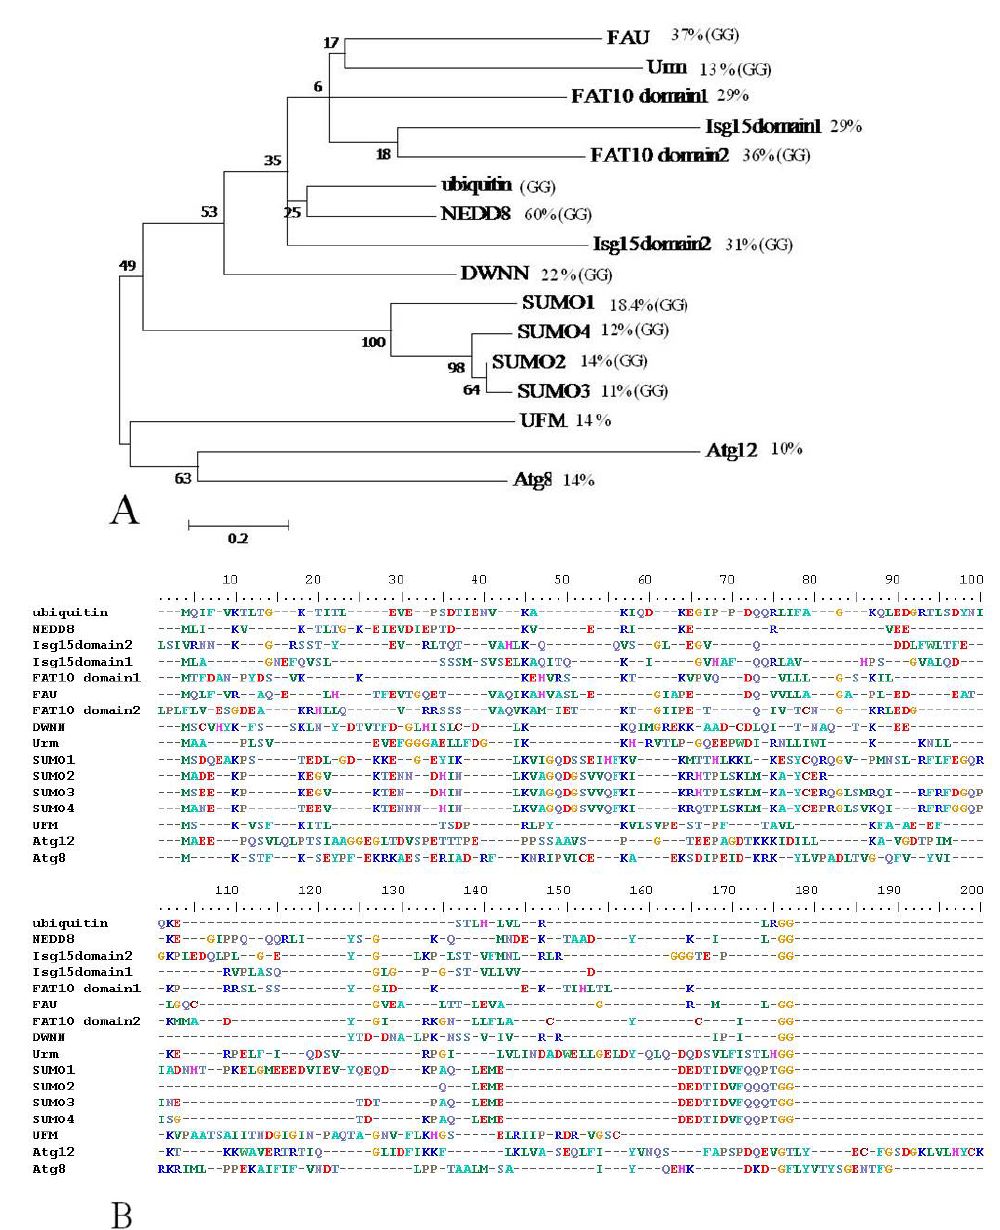
Figure 1. Phylogenetic analysis of ubiquitin-like modifiers and their protein sequence alignment. Protein sequences of the Ubl ubiquitin domains were initially aligned in MEGA 5, using the default ClustalW algorithm. The multiple sequence alignment was then analyzed and tweaked manually to ensure that important conserved residues (lysines, diglycine motif) were accurately aligned. The percentage similarity between each modifier and ubiquitin and the presence of a C -terminal di-glycine are marked on the phylogenetic tree ( A ). DWNN belongs to the group with proteins that have higher sequence identity with ubiquitin but it is the most distantly related in this group. The more distantly related UFM, Atg8 and Atg12 lack the conserved